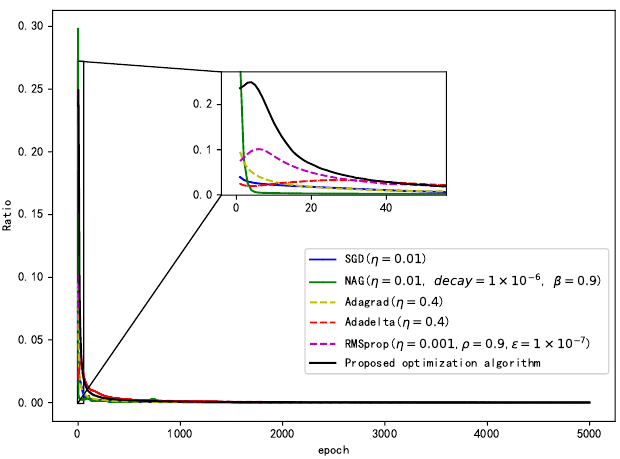
Figure 6. Weight update rate of different optimization